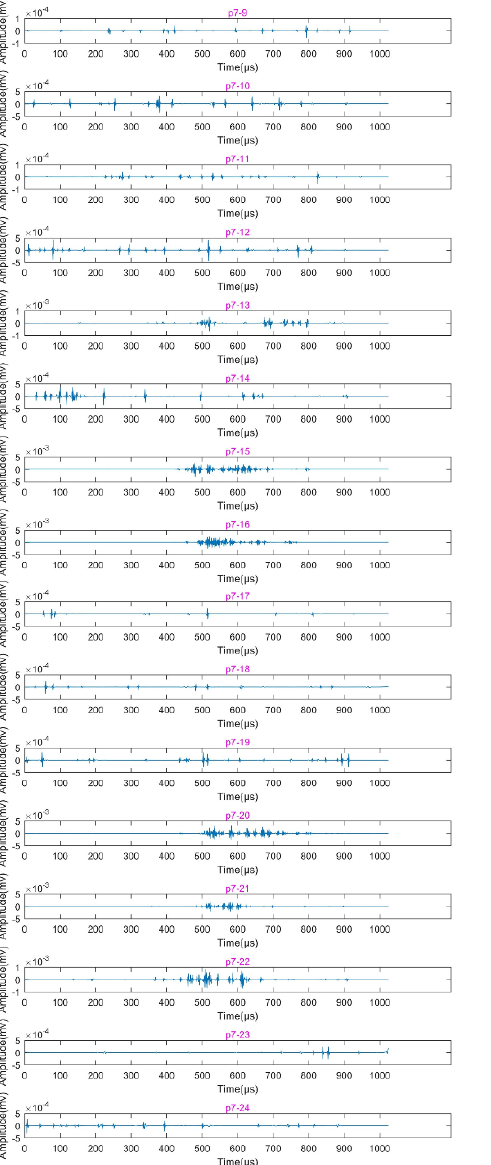
Figure 7. Reconstructed waveforms of signals with largest centroid frequency collected by sensors P7 and P10 in working cases 9–24 after lifting wavelet decomposition and filtering out the first layer low-frequency components. The waveforms of P7–13, P7–15, P7–16, P7–20, P7–21, P7–22, and P10–13 correspond to high-frequency fluctuations in various working cases shown in Figure 6. Table 4. Increment strains at vault and foot.